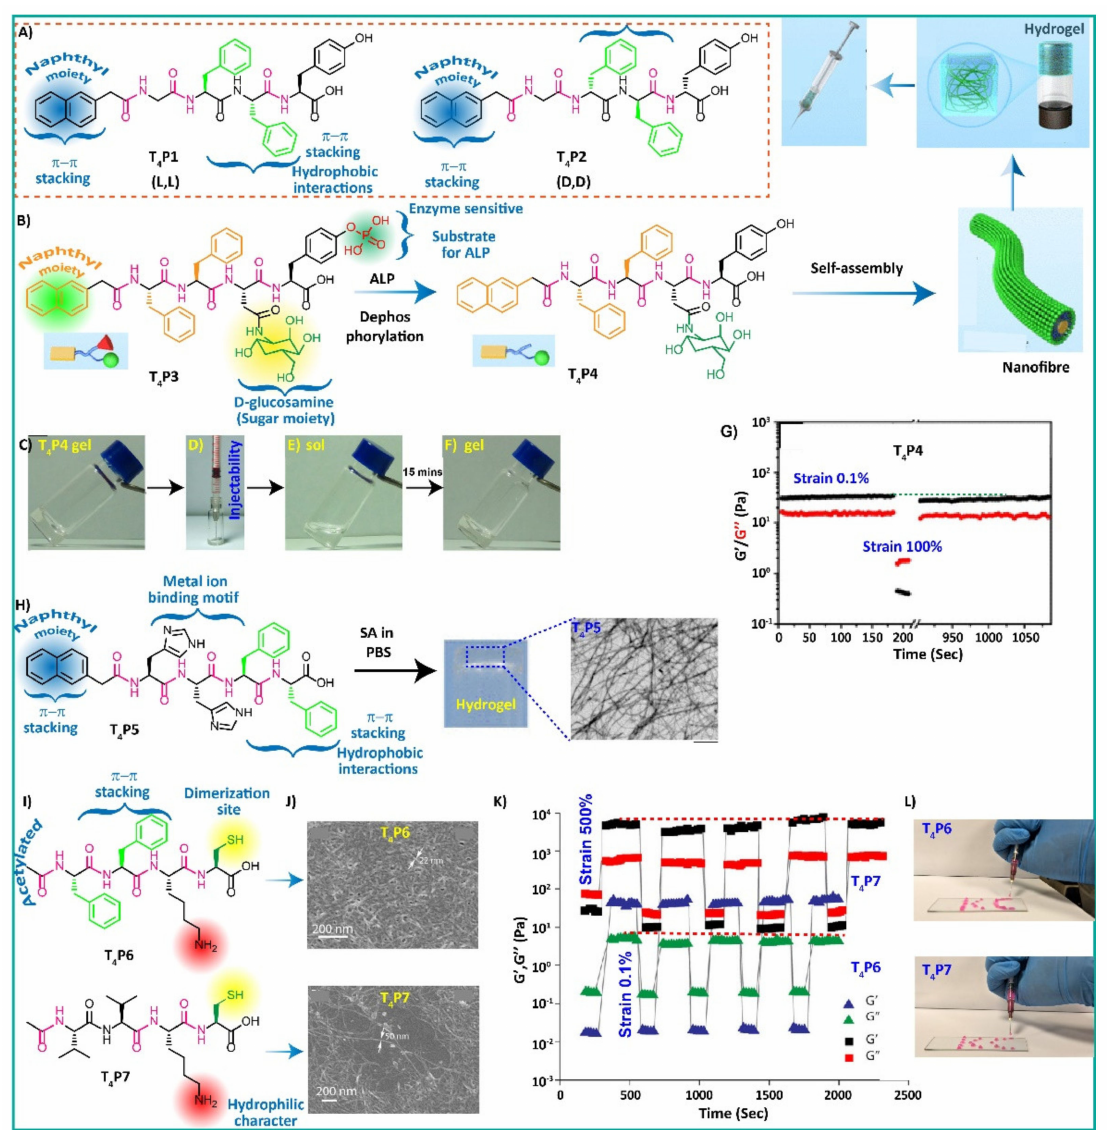
Figure 12. ( A ) Chemical structure of the tetrapeptide hydrogelators (T4P 1 and T4P 2 ); redrawn